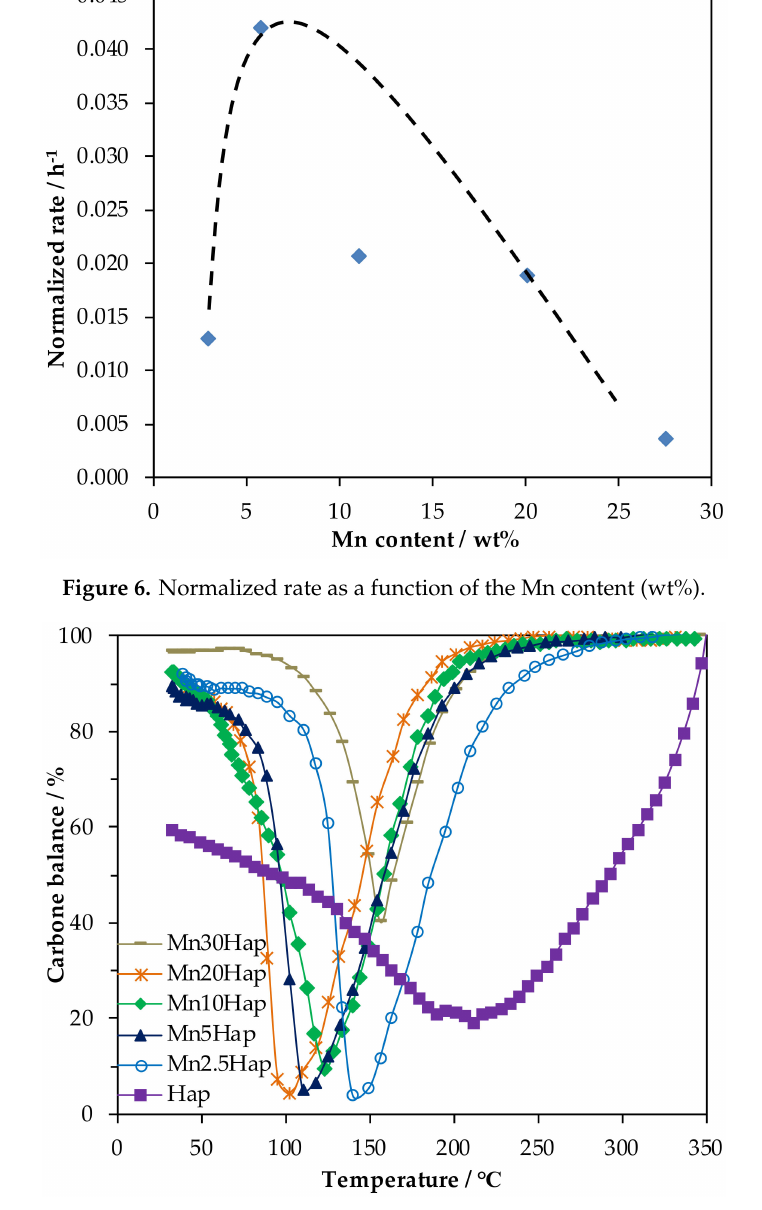
Figure 7. Carbon balance as a function of temperature for MnxHap